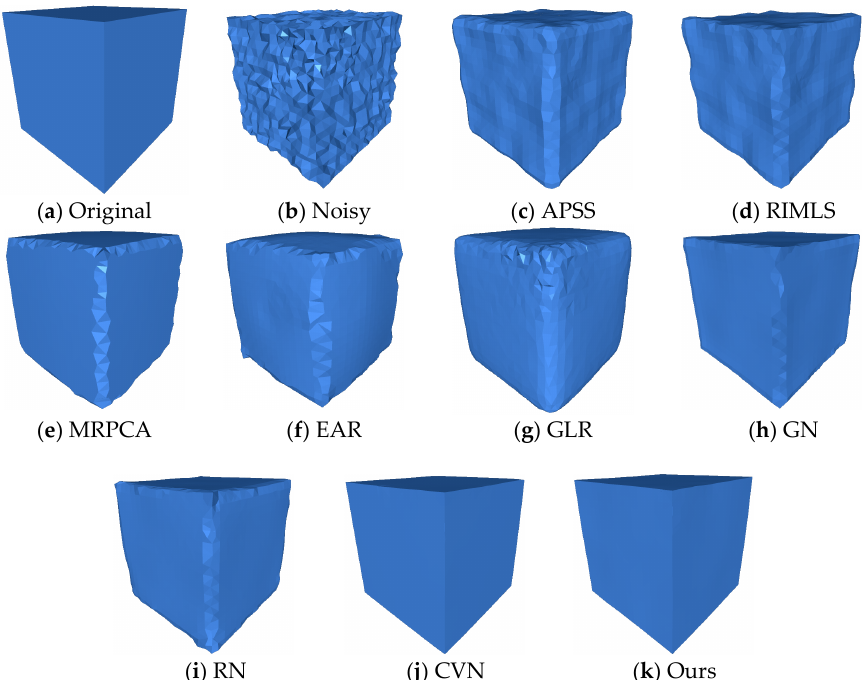
Figure 4. The Cube model with non-uniform distribution of points, corrupted by Gaussian noise ( σ = 0.3 h) along all directions, where h is the average distance between the points of the point